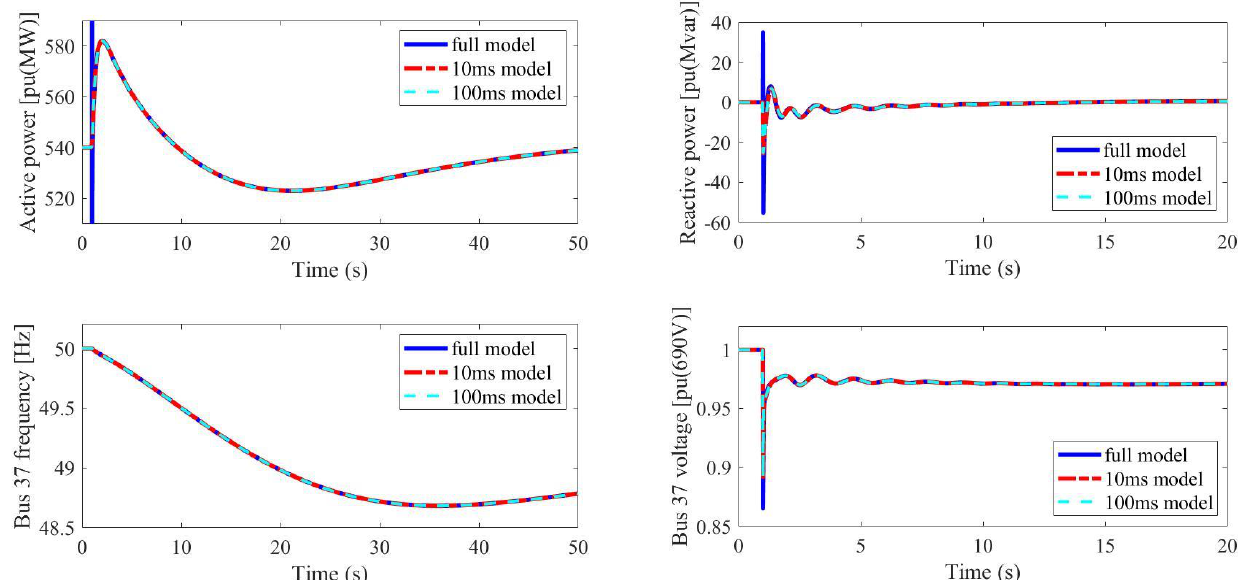
Figure 12. New England 39-bus system, Scenario 2: Generator outage.